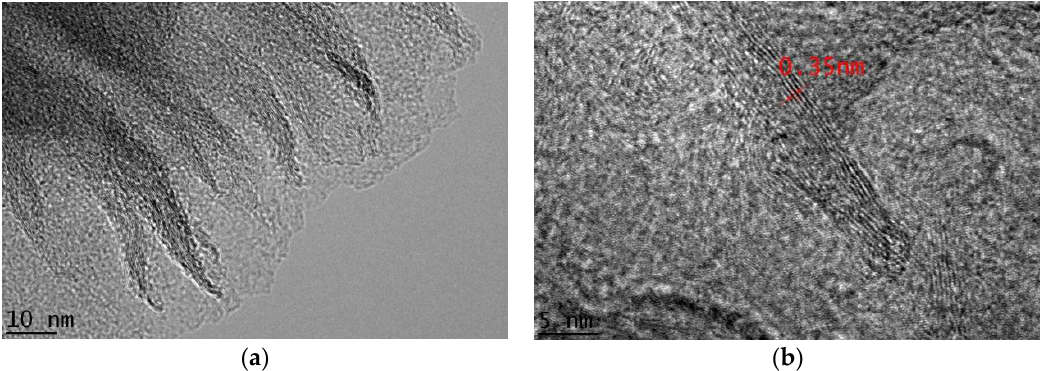
Figure 3. ( a ) Low-resolution TEM image of GNW and ( b ) high-resolution TEM image of GNW of several layers of graphene with an interspace layer of 0.35 nm.